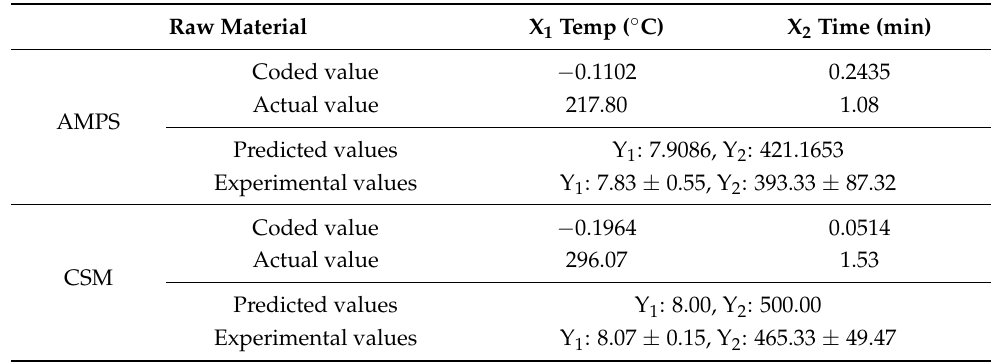
Table 4. Optimal cooking conditions of AMPS and CSM using response surface